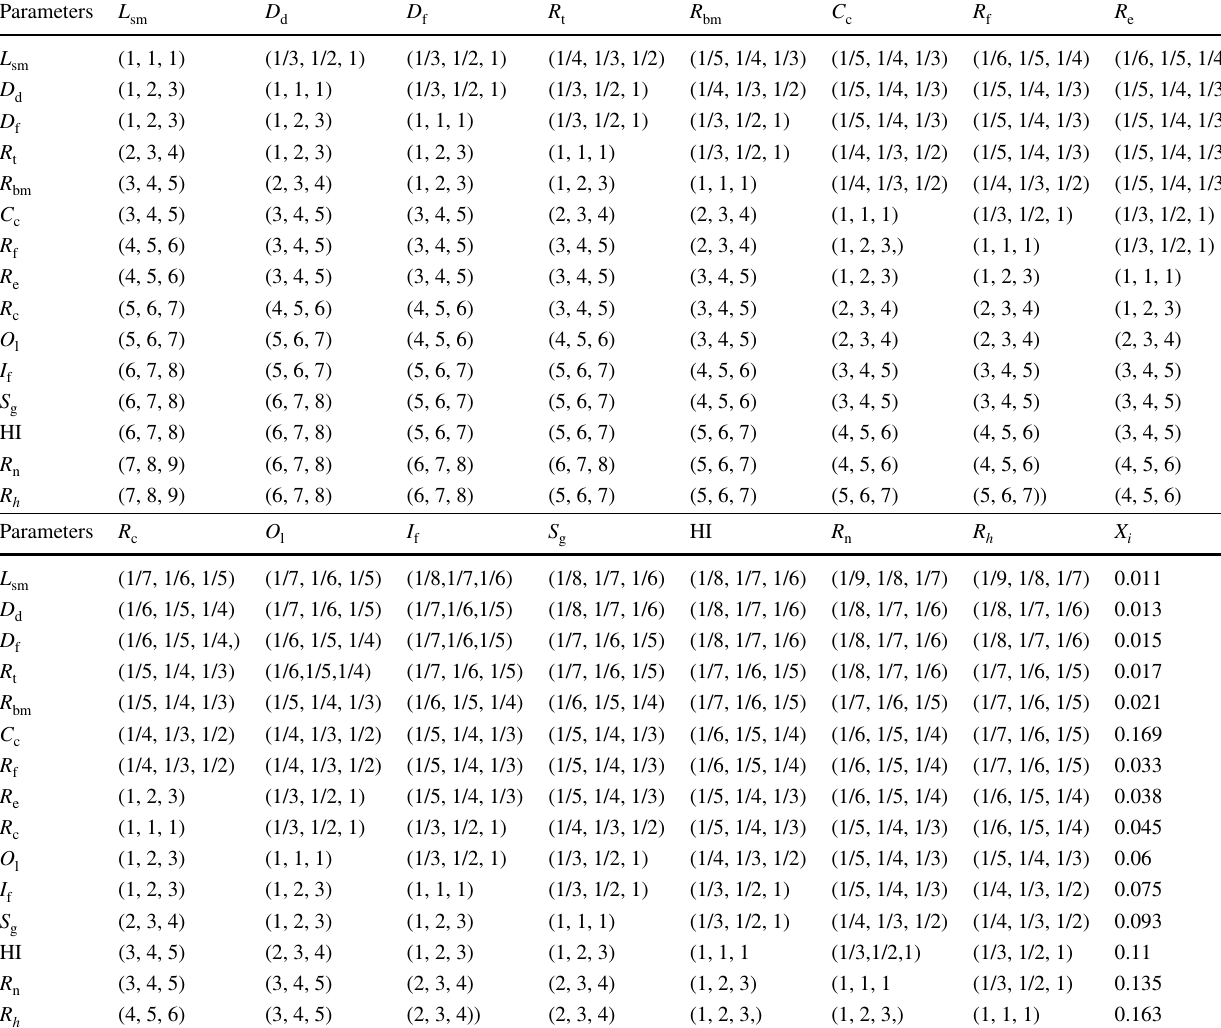
Table 5 Pair-wise comparison matrix for fuzzy AHP Parameters L